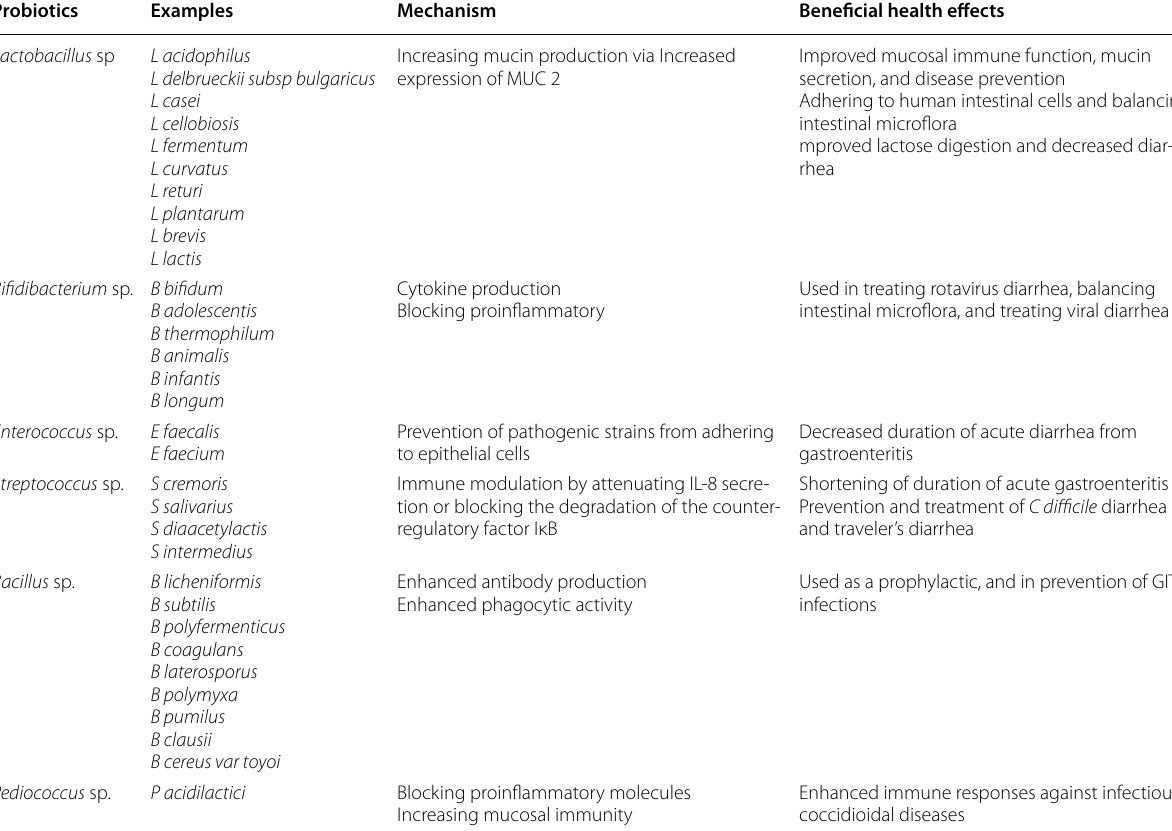
Table 1 The commonly used species in probiotics, mechanisms of action, and effects